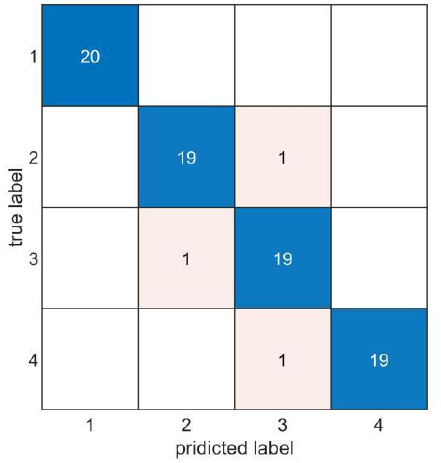
Figure 12. Confusion matrix of SSA-VMD-DPC.